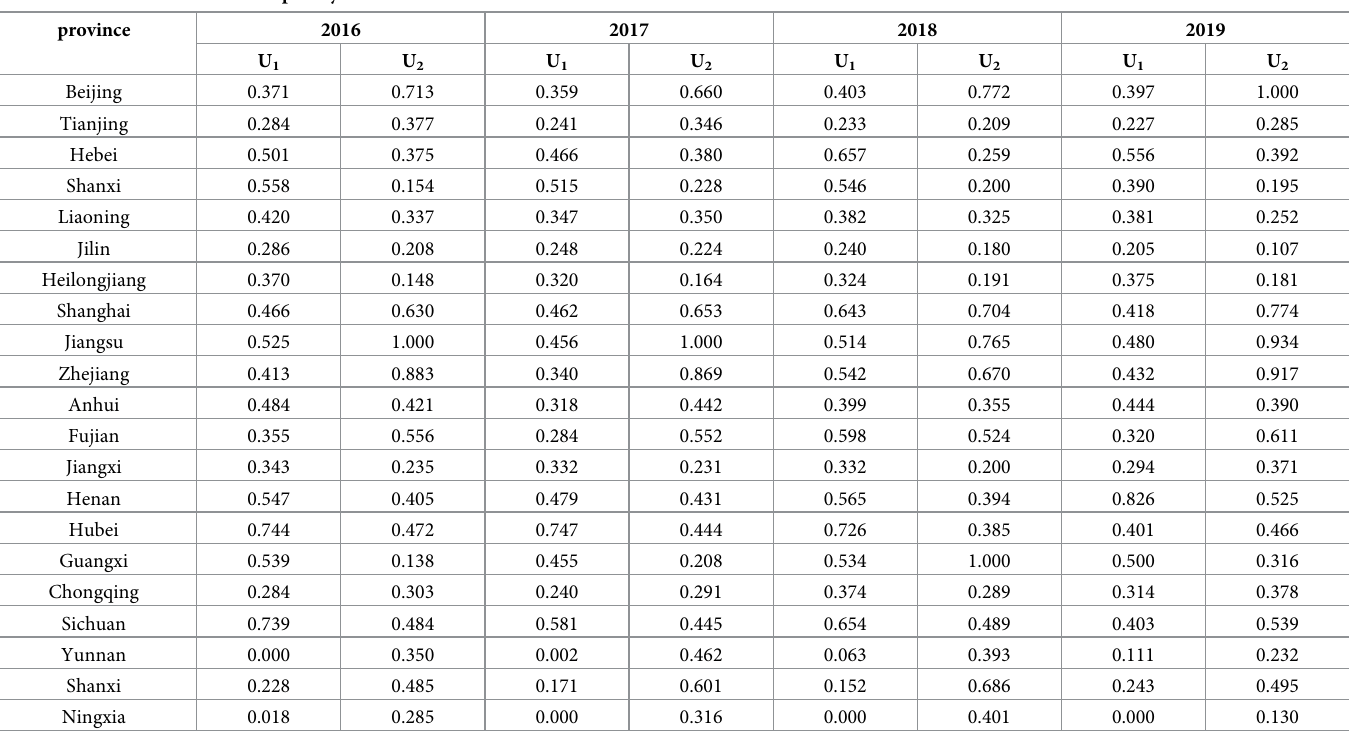
Table 6. Evaluation values for coupled systems.